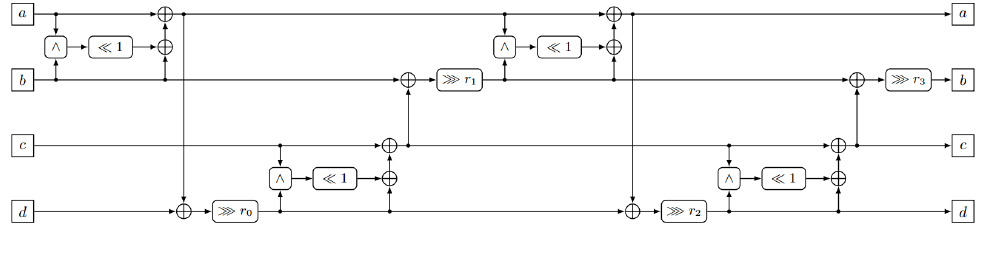
Figure 2: The G circuit (from